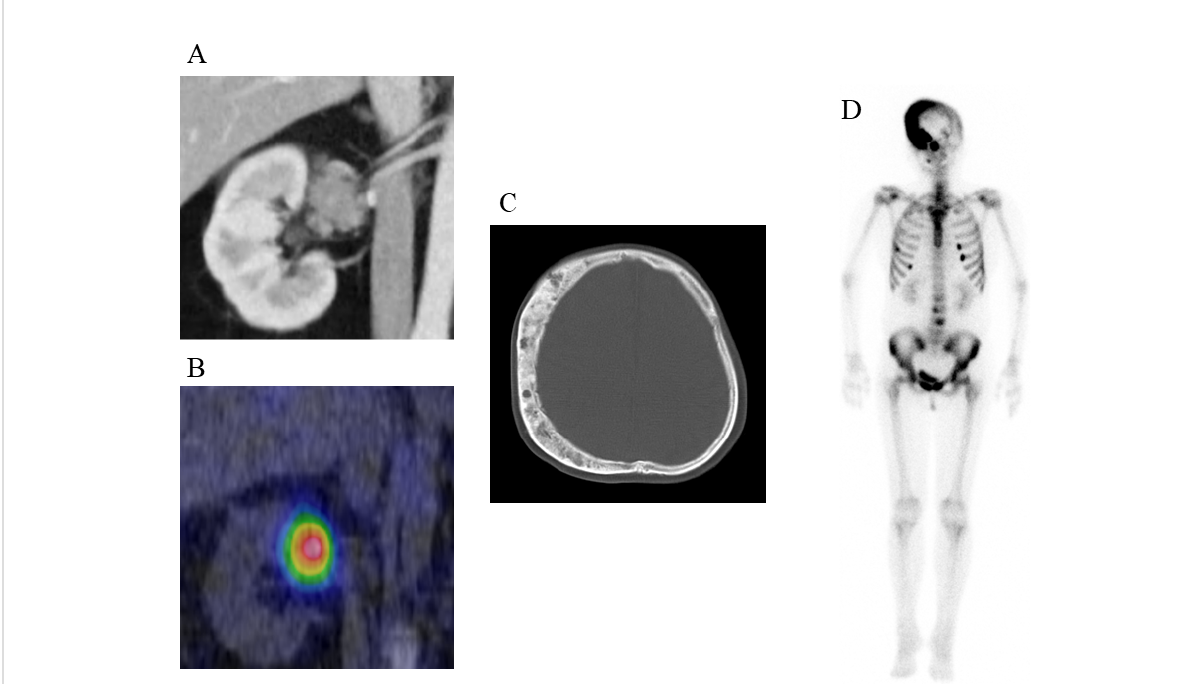
FIGURE 1 Clinical images of the patient (A) Enhanced CT scan showing a 40-mm round tumor with a relatively reduced contrast effect in the right renal hilum. (B) Remarkable 131 I-labelled adosterol accumulation in the tumor but not in the adrenal glands. (C) CT scan showing dissymmetric